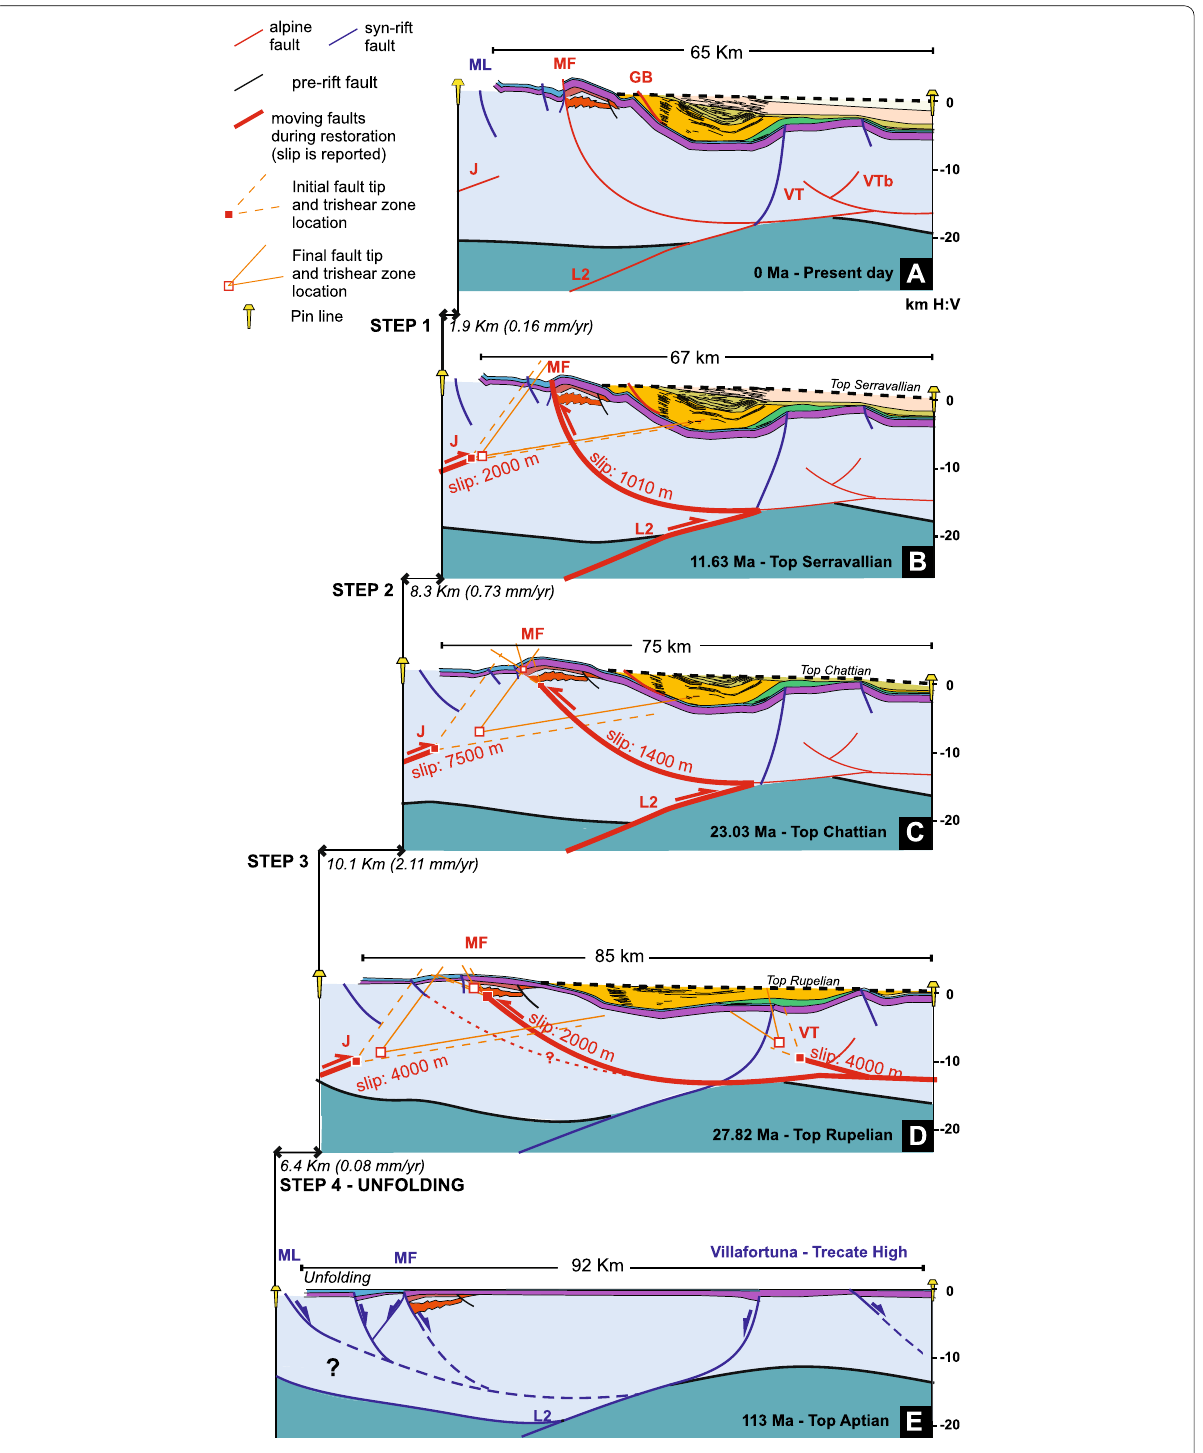
Fig. 9 Sequential restoration of the Varese section: a present-day, b top Serravallian, c top Chattian, d top Rupelian, e top Aptian—end of rifting. Fault slip values are listed on Table 1. See further comments on the